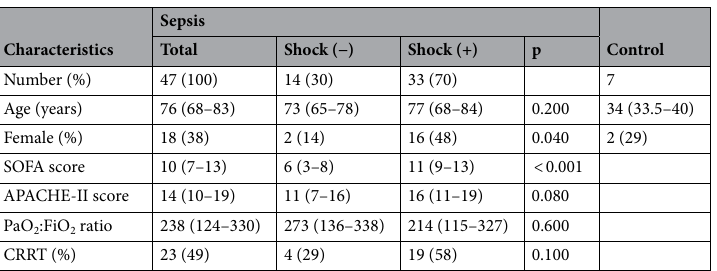
Table1. Characteristics of patients and healthy controls. The p values shown are the differences between the septic shock (−) group and shock (+) group: Mann–Whitney U-test for age, SOFA score, APACHE II score, and PaO 2 :FiO 2 ratio, and Fisher’s exact test for sex distribution and CRRT ratio. Data are expressed as median (interquartile range). SOFA sequential sepsis-related organ failure assessment; APACHE Acute Physiology and Chronic Health Evaluation; PaO 2 partial pressure of arterial oxygen; FiO 2 fraction of inspired oxygen; CRRT continuous renal replacement